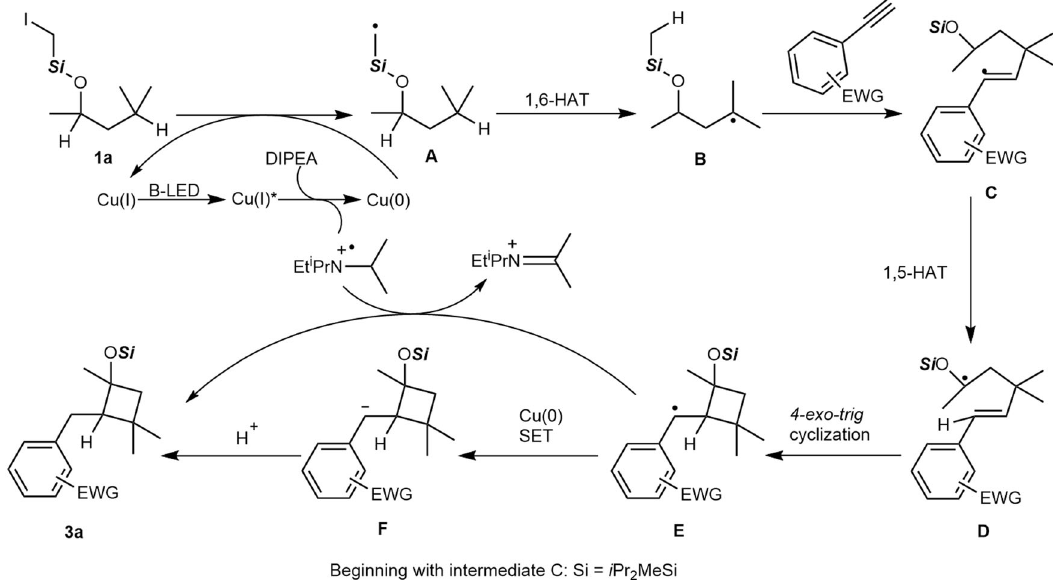
Fig. 5 Proposed reaction mechanism. Photoredox-based dehalogenation of 1a triggers a 1,6-HAT ( A to B )/vinyl radical formation ( C )/cyclization cascade reaction ( D , E , F ) involving the functionalization of two C − H bonds to form valuable cyclobutanols ( 3a ).